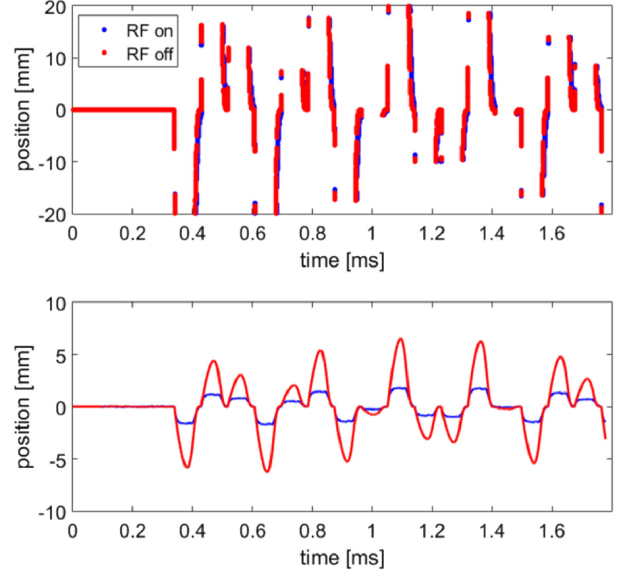
FIG. 9. Transverse beam position during a quench in 4K LHe (top) and 2K LHe (bottom) for a KEKB-like cavity, with the rf kept on (blue) or switched off (red) when a quench is detected.